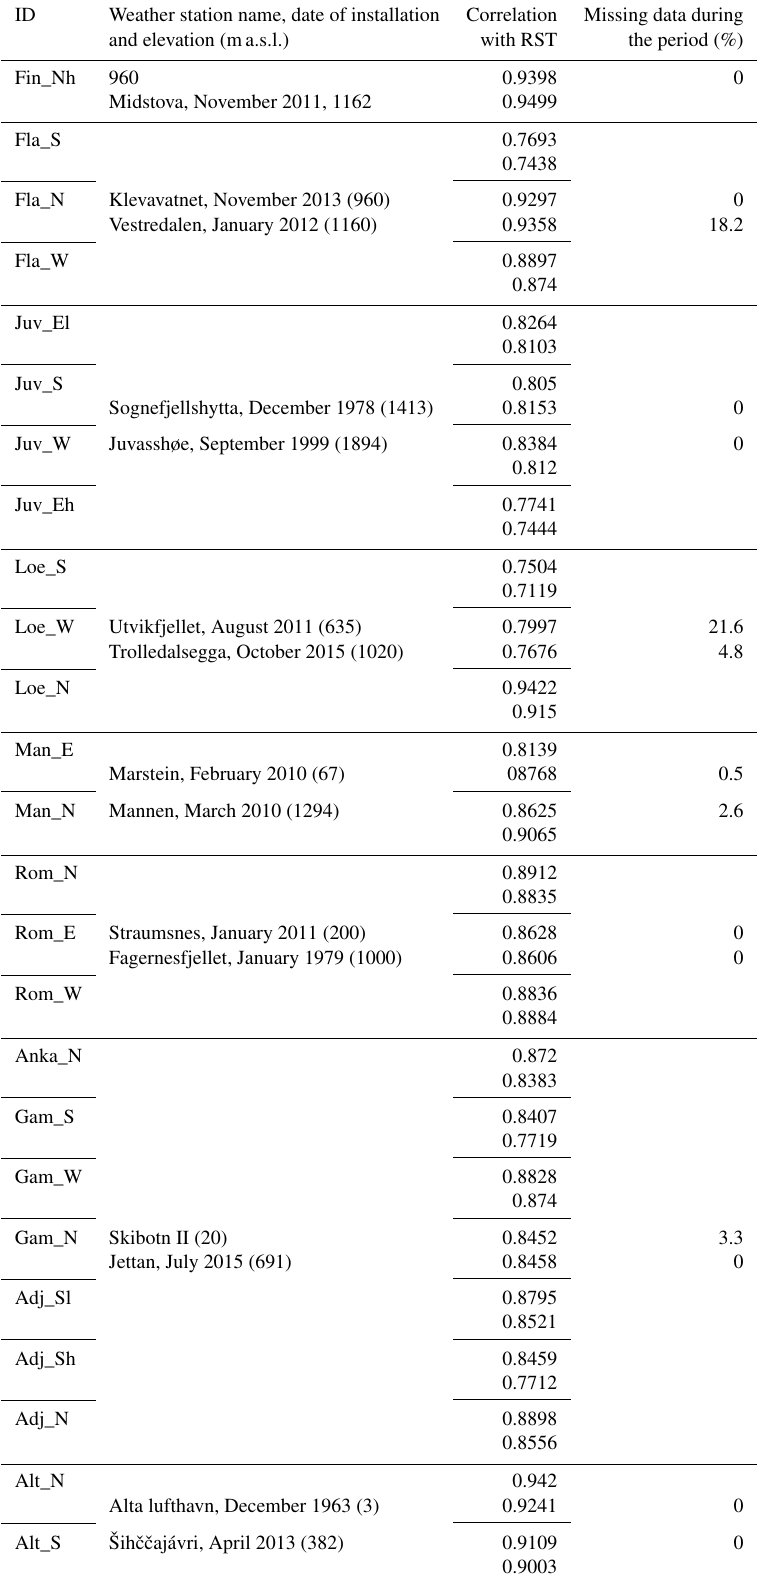
Table 3. Summary of the data used for the MAAT